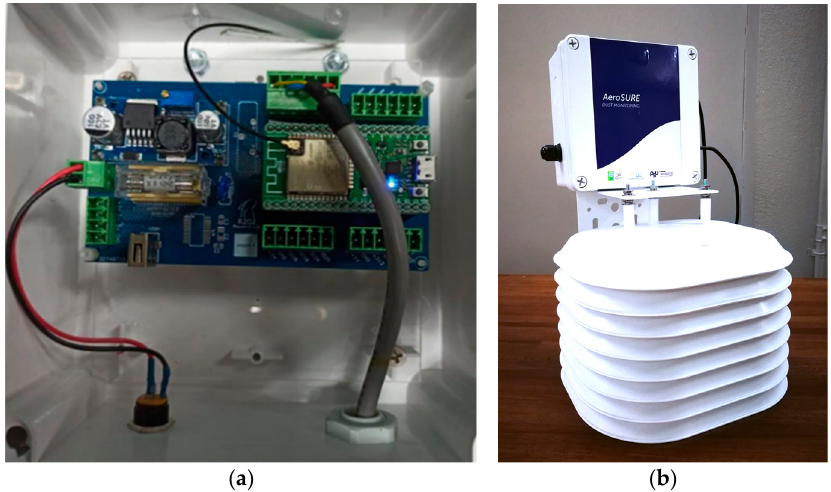
Figure 1. ( a ) Custom designed printed circuit board and its components for the Plantower PMS7003 sensor package; ( b ) closed louver box housing all components for outdoor monitoring.